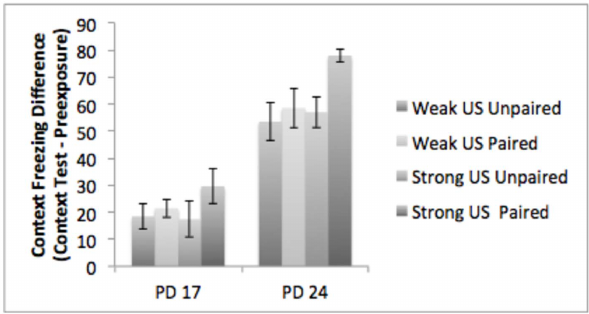
Figure 5. The results of Experiment 2 – contextual condition- ing. PD 24 subjects showed significantly enhanced freezing to the conditioning context compared to PD 17 subjects regardless of shock